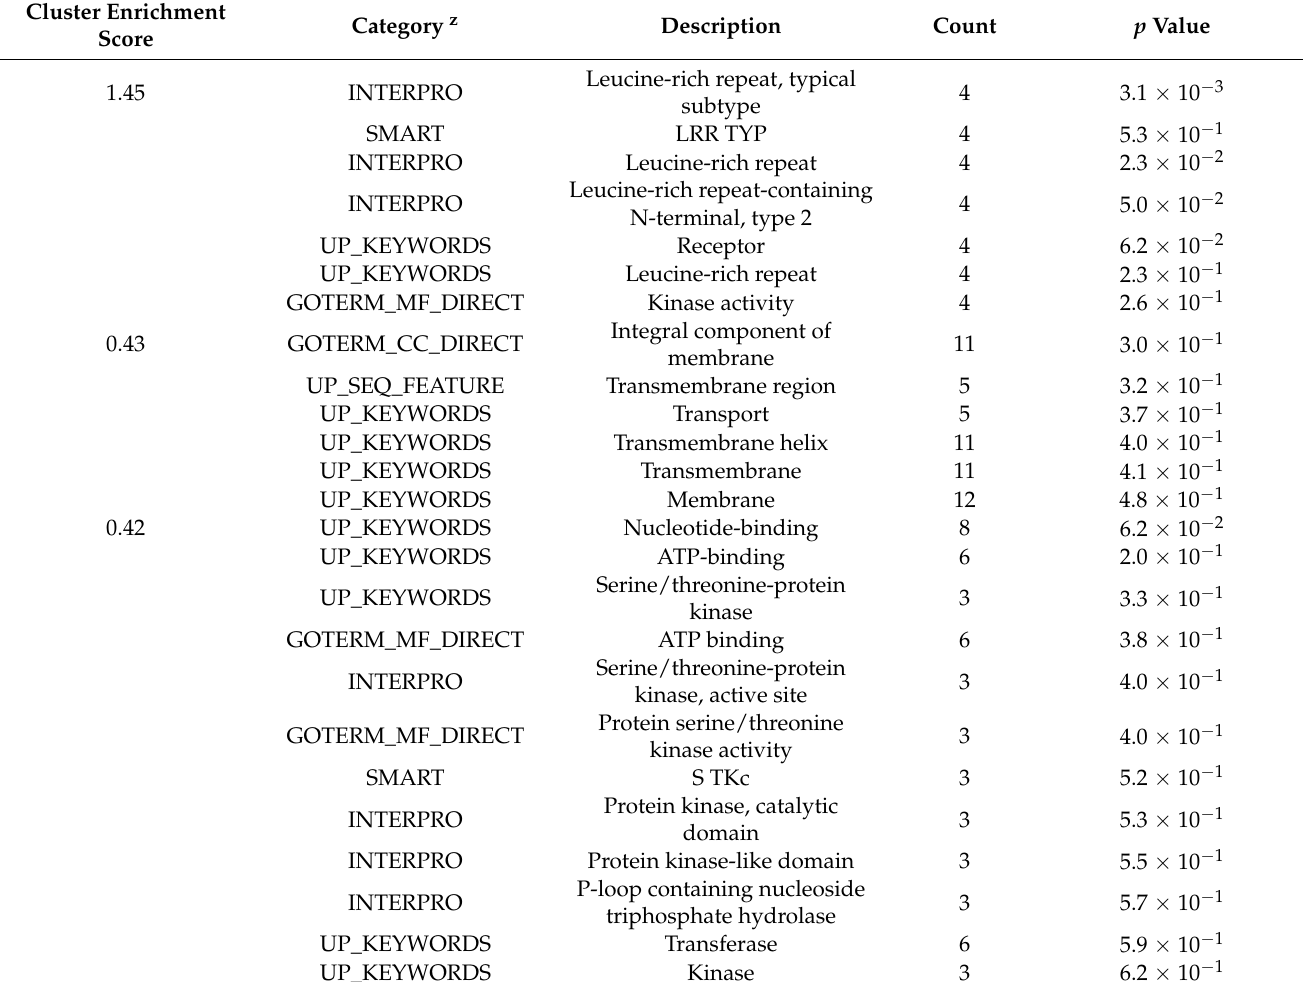
z The terms derived from reference databases. INTERPRO, terms from InterPro protein database; SMART, analysis of domain architectures; UP_KEYWORDS, keywords from UniProtKB; GOTERM_MF, Gene ontology term of molecular function; GOTERM_CC, Gene ontology term for cellular component; UP_SEQ_FEATURE, Uniprot Sequence